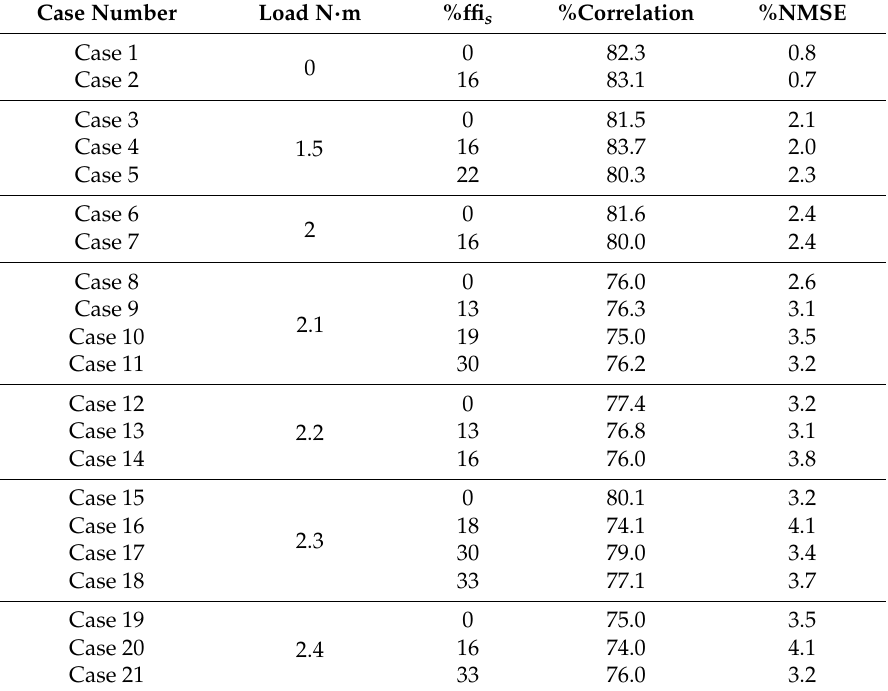
Table 2. The percentage correlation and normalized mean square error (NMSE) of simulated cases.